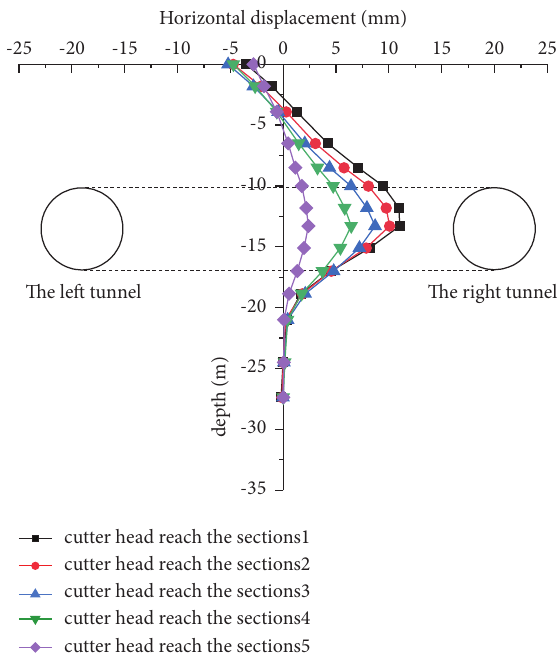
Figure 21: The right tunnel excavation gap